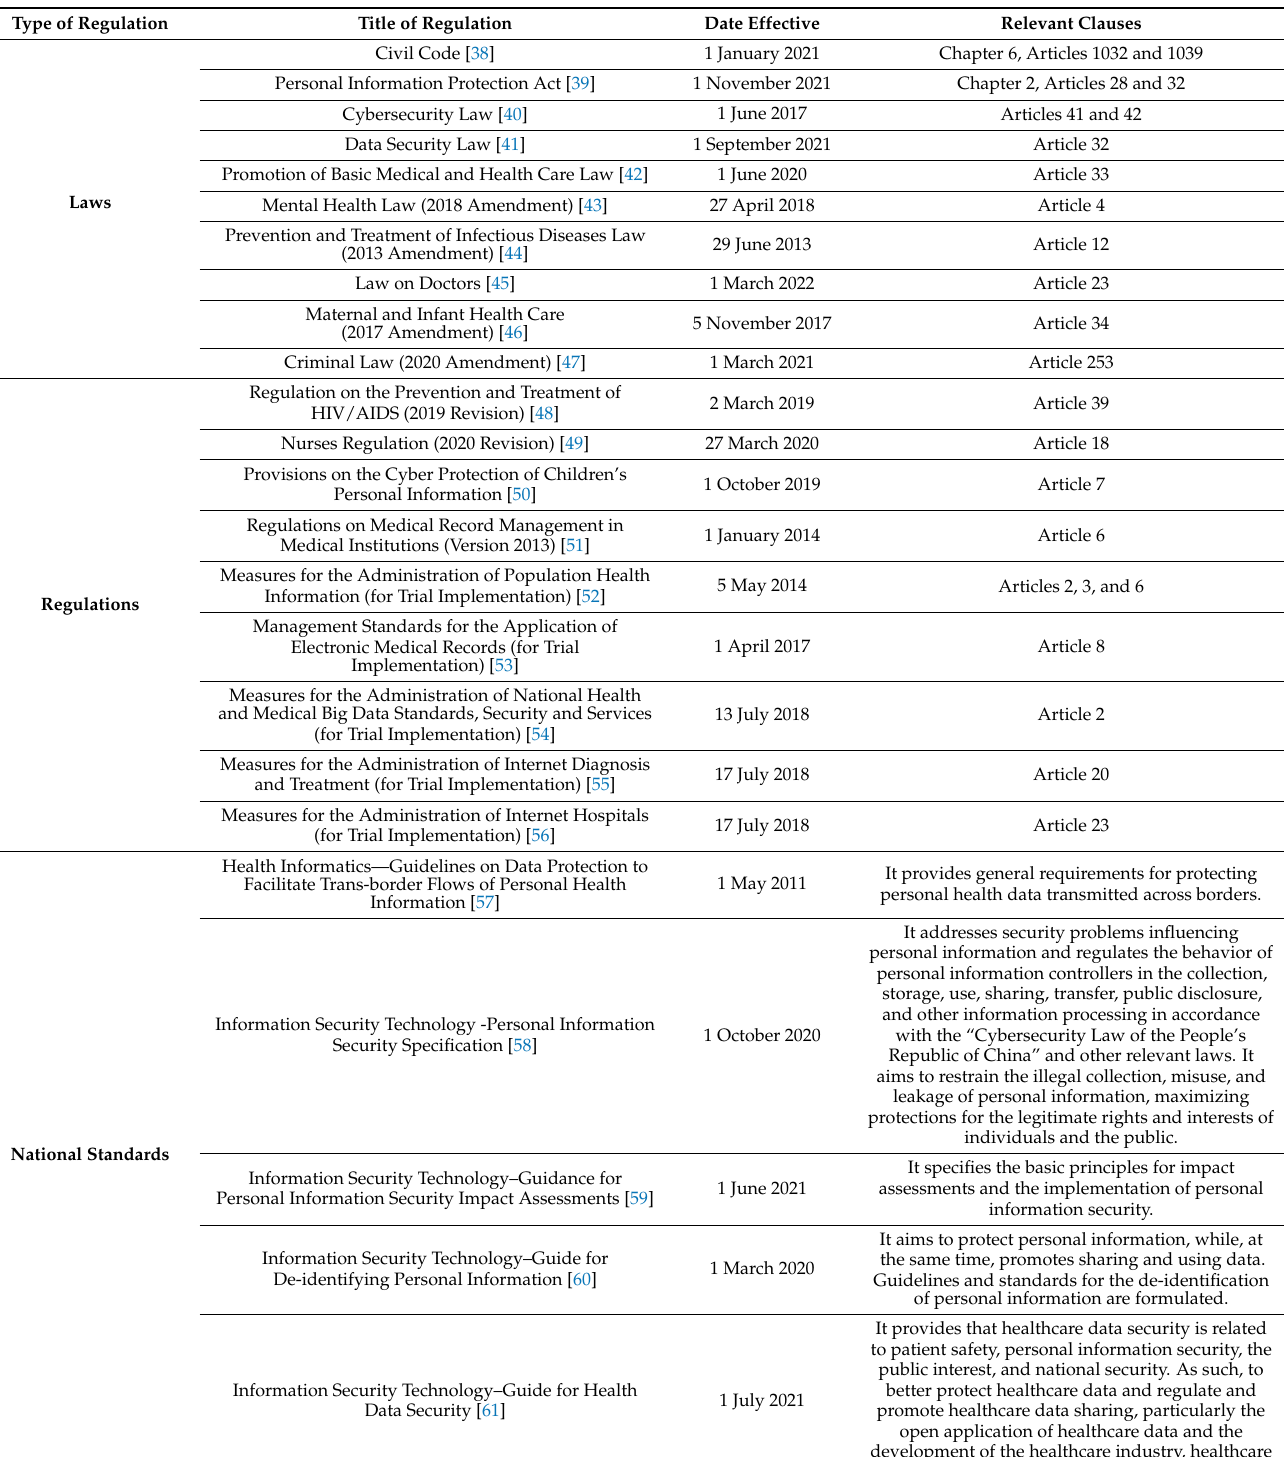
Table 1. Chinese laws, regulations, and national standards for privacy protection in medical